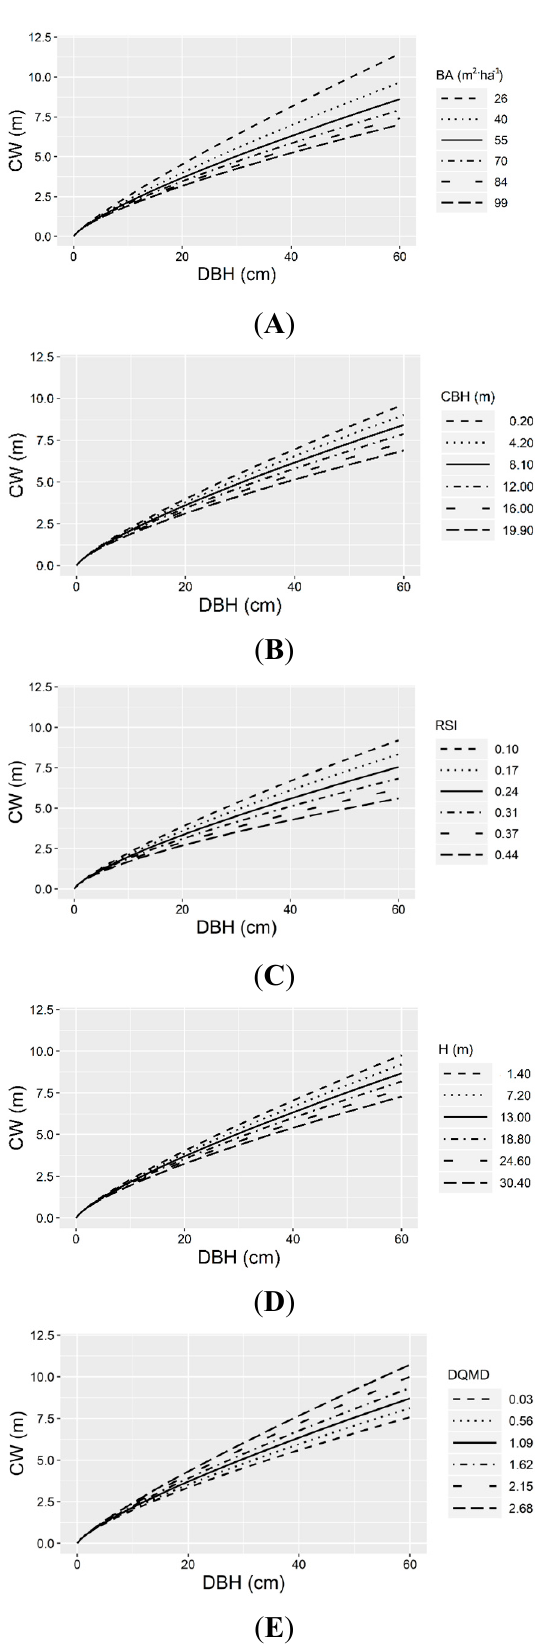
Figure 4. Effects of the GM2 model’s covariates (( A ) BA, ( B ) CBH, ( C ) RSI, ( D ) H, and ( E ) the diameter/quadratic mean diameter, DQMD) on the crown width of Black